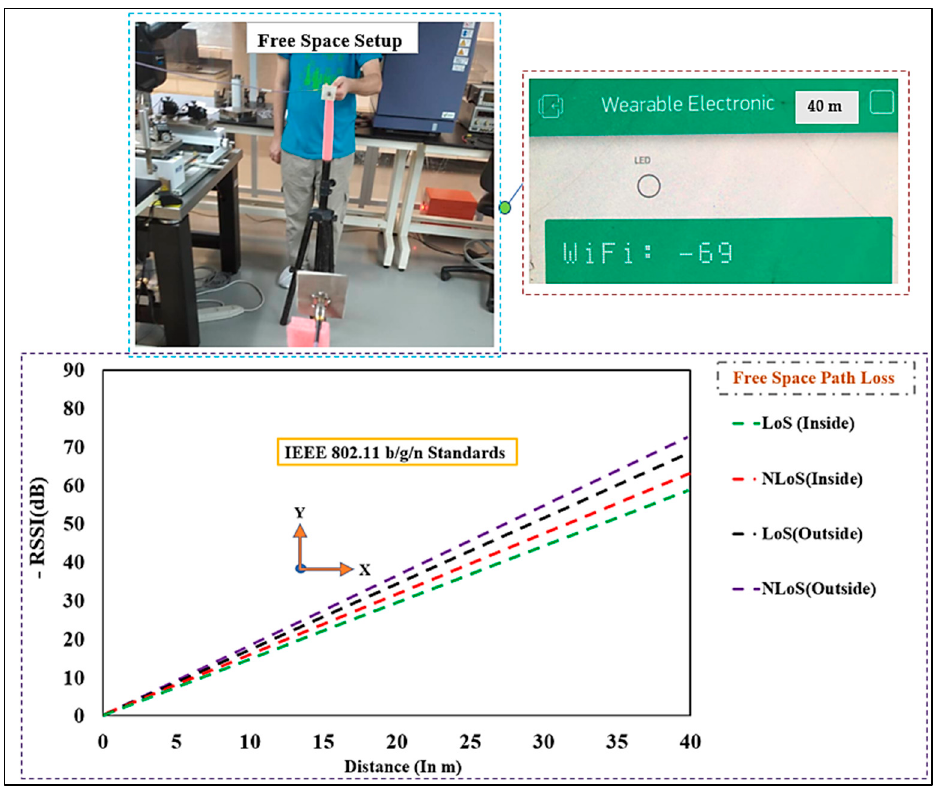
Figure 26. Measured received signal strength indicator (RSSI in dB) in free-space scenarios (Distance: 2 m to 40 m).